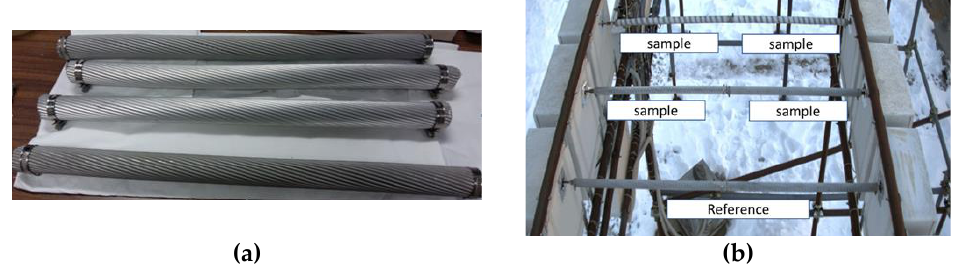
Figure 6. ( a ) Pieces of conductor 0.75 m long; ( b ) typical experimental set-up in WILD station. During the testing period, nine snowfall events were recorded at the WILD station from December to April. The main meteorological and physical variables of snowfall events are reported in Table 4 (see Supplementary Material for further data). Table 4. Main meteorological parameters of the snowfall events (T ave : average temperature; WE: water equivalent; H snow : height of snow deposition on the ground).